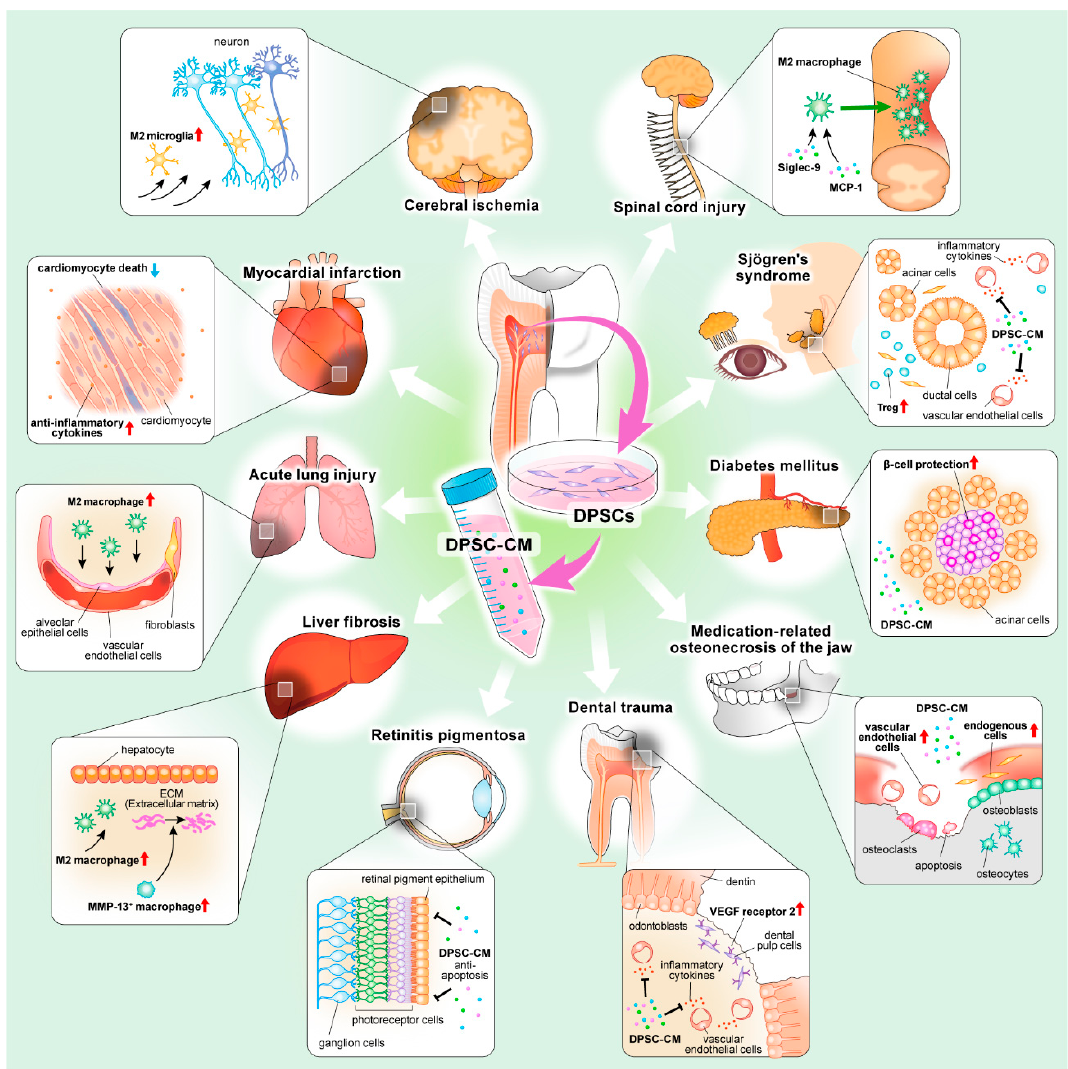
Figure 1. Schematic representation of therapeutic potential summary of DPSC-CM.